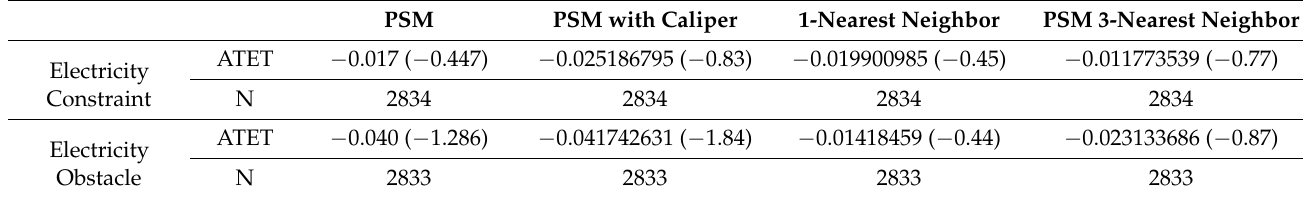
Table 6. ATET estimates for access to electricity.